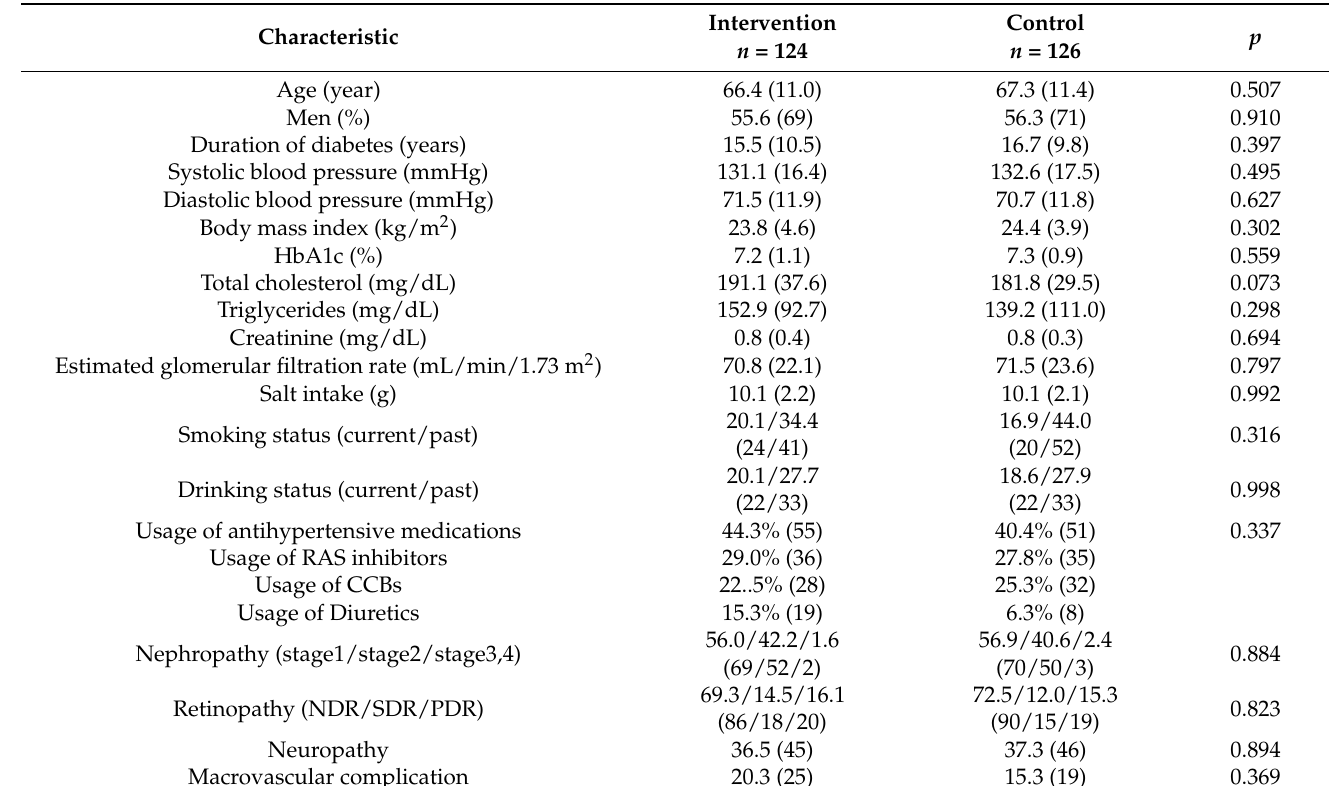
Table 1. Clinical characteristics of study patients.